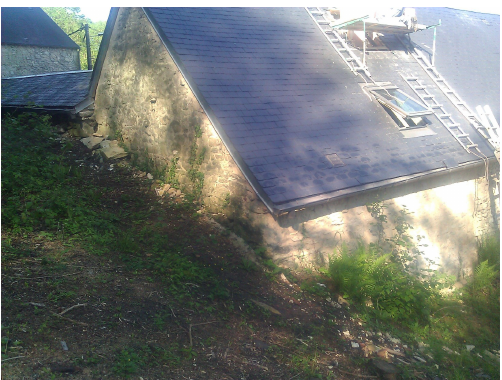
Figure 6. Building in which the aeraulic device is